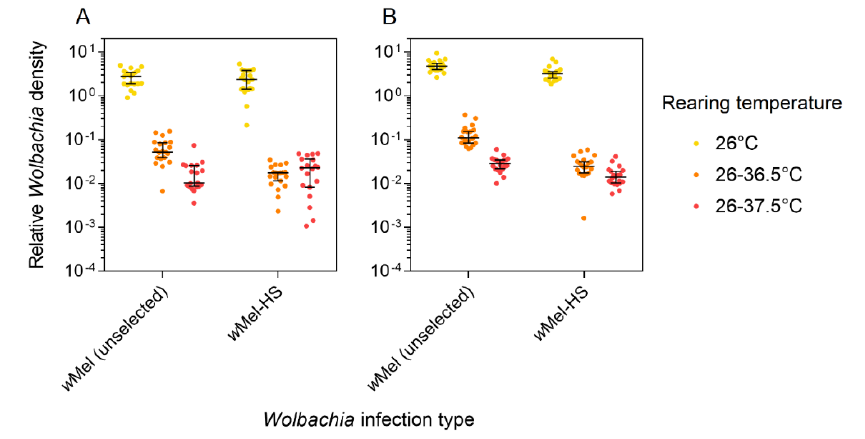
Figure 3. Relative Wolbachia density after five generations of heat stress selection. Females ( A ) and males ( B ) from the w Mel (unselected) and w Mel-HS lines were reared under three temperature conditions. Black bars indicate median densities with 95% confidence intervals.